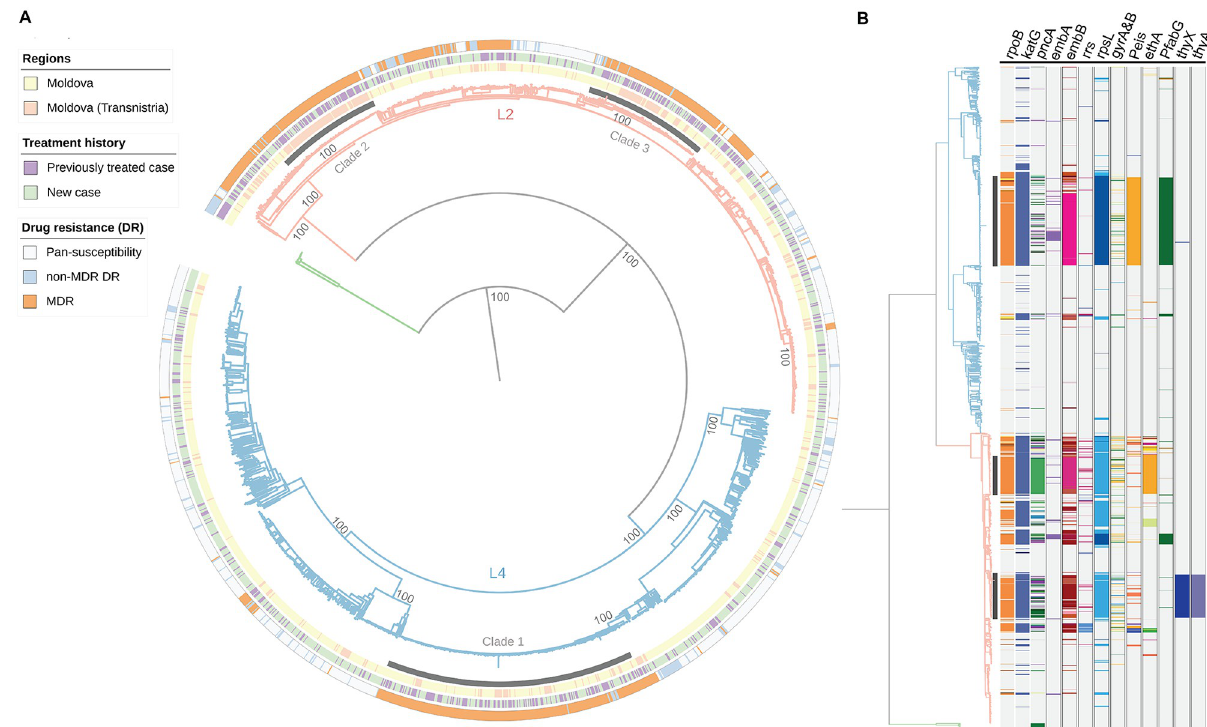
Fig 2. (A ) M–L phylogeny of 1,834 Moldova M . tuberculosis isolates based on 43,284 variable sites. The outer bands represent the in silico drug- resistant profiles, treatment history of participant and the region where the isolates were sampled from. The tree is rooted to Mycobacterium bovis (branch in green). L2 denotes lineage 2 (light orange) and L4 lineage 4 (light blue). Three major clades from the Ural/ lineage 4.2.1 (clade 1) and Beijing/lineage2.2.1 (clades 2 to 3) are shaded. The main nodes of the tree have 100% bootstrap support. (B) Phylogenetic distribution of resistance- related genotypes. The columns depict loci associated with drug resistance. “P” followed by a subscription of gene name indicates the promotor region. Colored bands of each column represent different polymorphisms. DR, drug resistance; MDR, multidrug resistance; MDR-TB, multidrug-resistant tuberculosis; M–L,